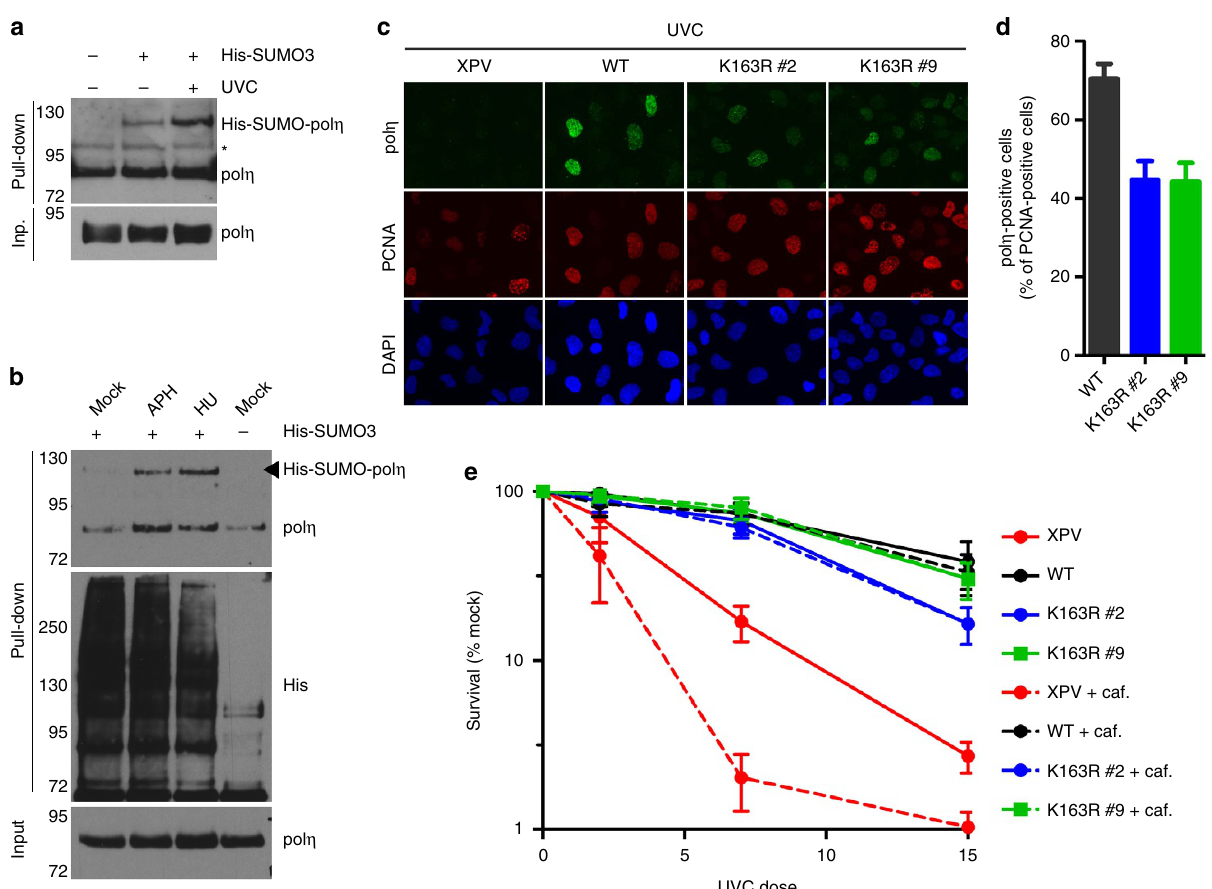
Figure 5 | SUMOylation of pol g increases after replication stress while has a minor impact on pol g function at ultraviolet-induced DNA lesions. ( a , b ) XPVcells stably expressing pol Z WT were transfected with His-SUMO3. 24h after transfection, cells were irradiated at 20Jm (cid:3) 2 and incubated for 6h ( a ) or treated with 0.3 m M APH or 0.2mM hydroxyurea (HU) for 24h ( b ) before performing denaturing Ni pull-down. Bound material was analysed by immunoblotting using the indicated antibodies. *unspecific band. ( c , d ) XPV cells stably expressing pol Z WT or pol Z K163R were irradiated with ultraviolet-C (20Jm (cid:3) 2 ), incubated for 6h and processed as described in Fig. 4a–d. ( e ) XPV, pol Z WT and pol Z K163R cells were irradiated with ultraviolet-C at the indicated doses and incubated for 72h in medium supplemented or not with 0.38mM caffeine. Living cells were counted in the presence of trypan blue. Data are expressed as the percentage of living cells compared with mock-treated cells (mean ± s.d. of four independent